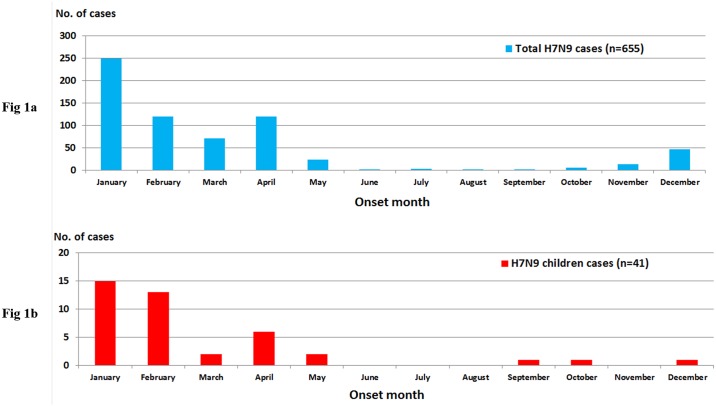
Monthly distribution curve for the total confirmed cases and childhood cases of avian influenza A(H7N9) between February 18, 2013, and June 13, 2016.Notes: Fig 1a: Total cases (N = 655); Fig 1b: Childhood cases (N = 41).